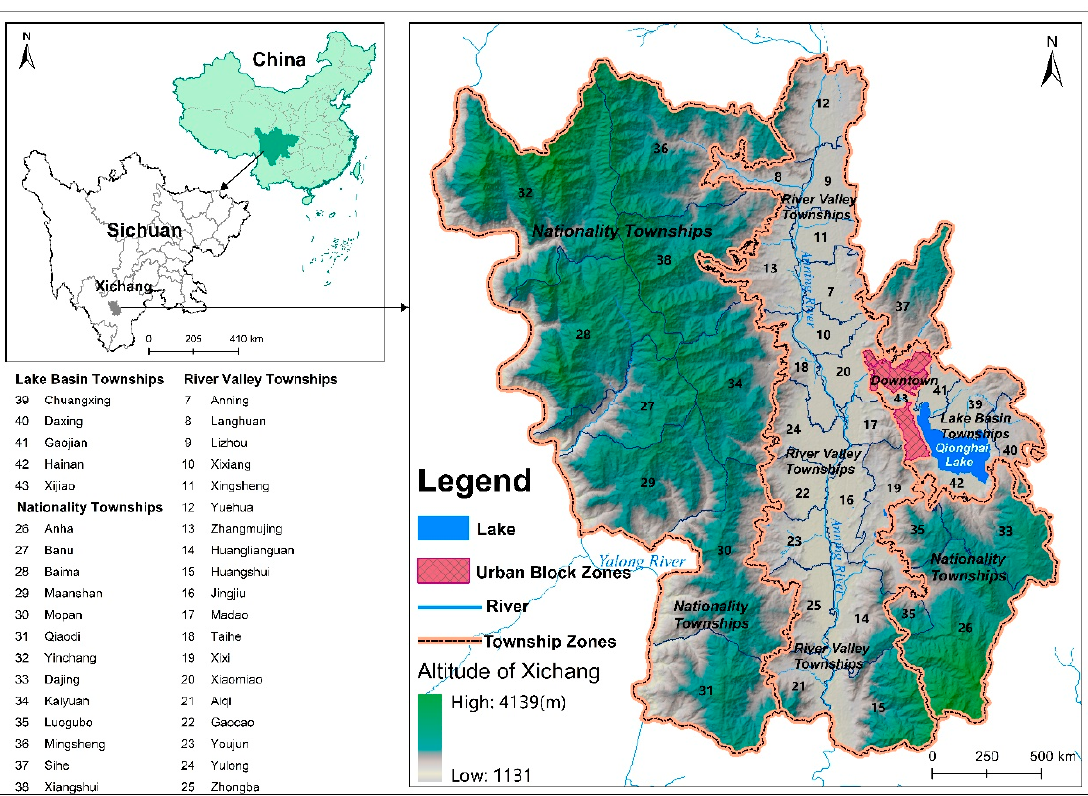
Figure 2. Overview of the study area and township zones.